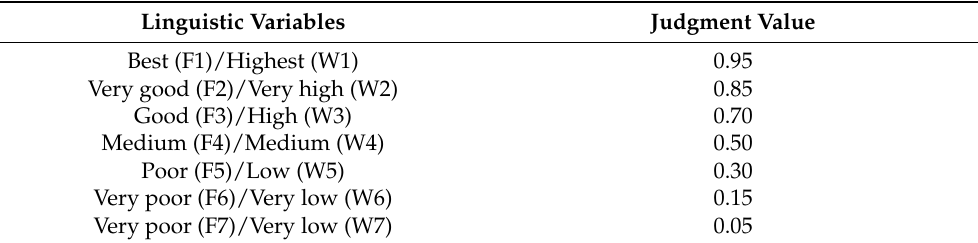
Table 2. Correspondence between linguistic variable values and evaluation